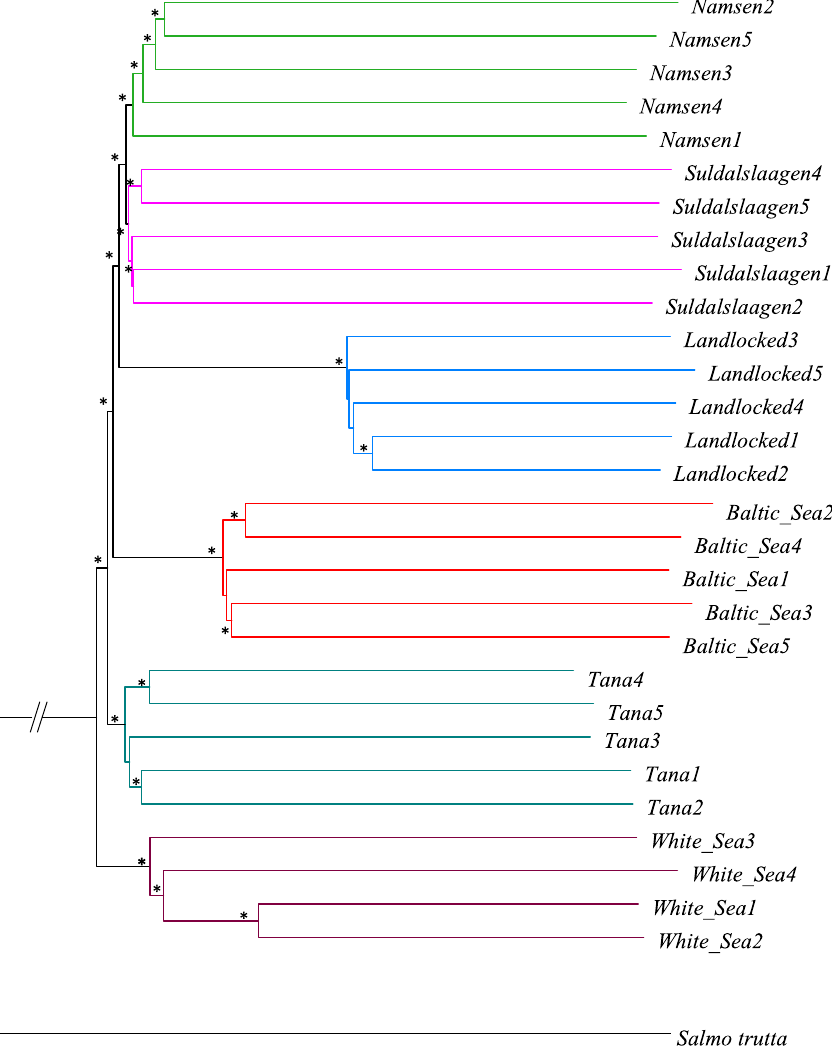
Figure 1. Phylogenetic relationship among the salmon populations from six locations in Norway. The brown trout was used as an outgroup to root the tree. The NJ tree was constructed using the whole genome data and the bootstrap confidence values were based on 500 replicates. The asterisk (*) denotes 100% bootstrap support. However, the nodes without an asterisk have > 80% but < 100% bootstrap